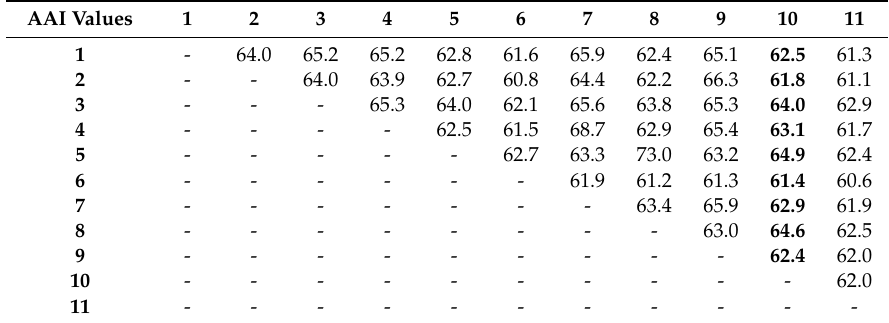
Table 1. Average Amino Acid Identity (AAI) percentages, highlighted in bold, between strain F16- 60 T and other species and genera from the order Halobacteriales .